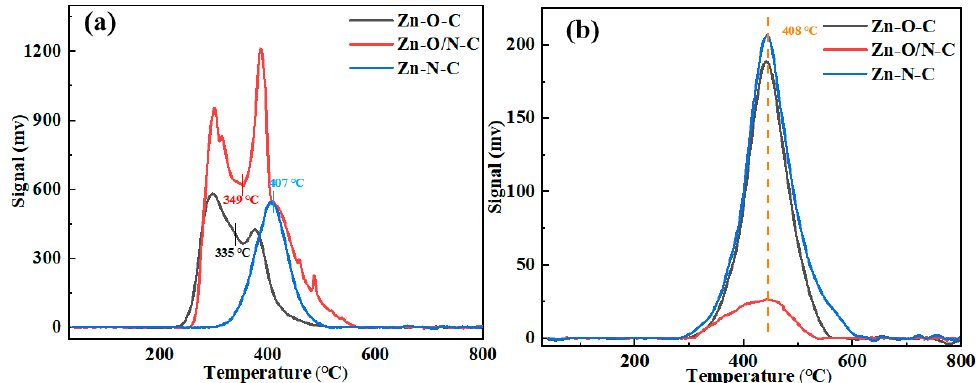
Figure 6. TPD analysis of Zn-O-C, Zn-O/N-C, and Zn-N-C: ( a ) CH 3 COOH and ( b ) C 2 H 2 .